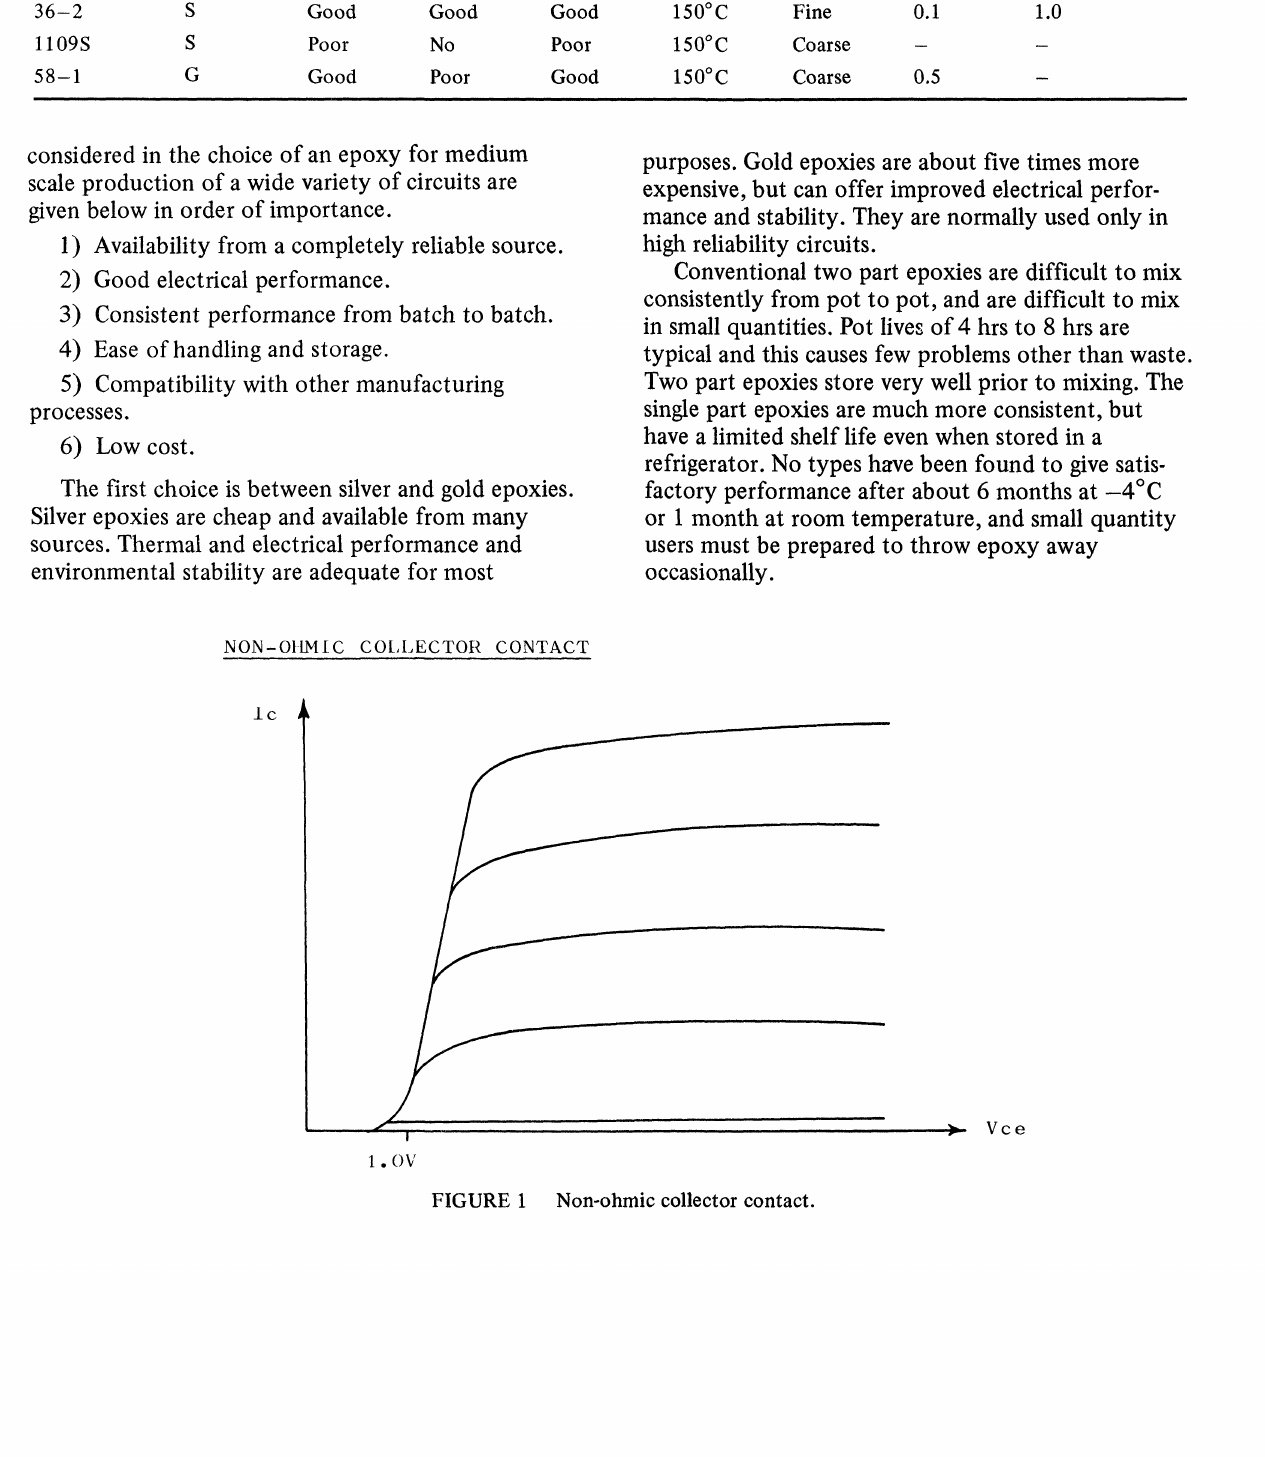
FIGURE Non-ohmic collector